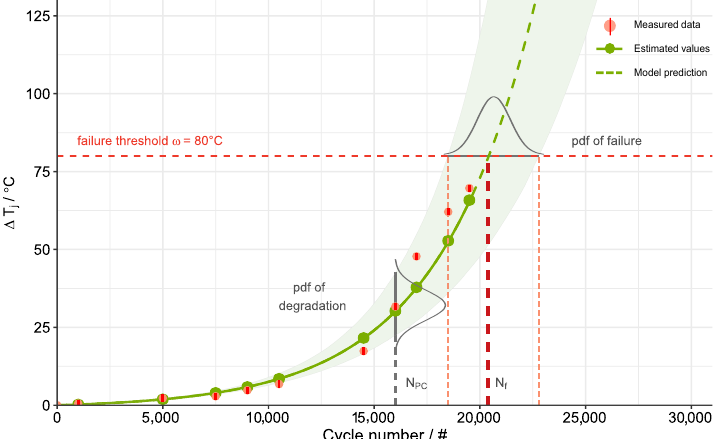
Figure 12. Bayesian RUL prediction of LED systems as proposed in [43]: Measured data (red circles) with error bars representing the measurement uncertainty obtained from 20 repeated measurements on a single LED device under constant conditions, i.e., ± 2 ˜ σ with ˜ σ ≈ 0.5 ◦ C; estimated values (green circles); and predictions of ∆ T j (green dashed line). Probability density function (pdf) of failure based on a failure threshold used to indicate